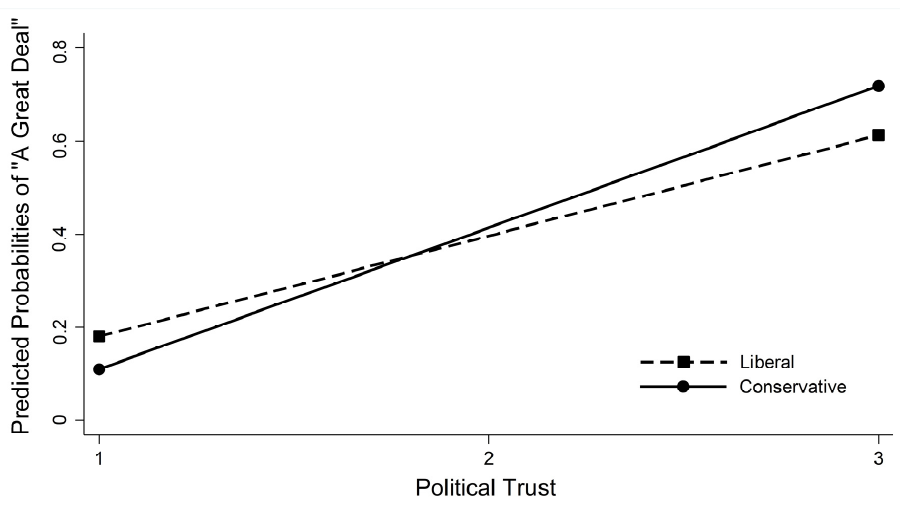
Figure 1. Predicted probabilities of support for “a great deal” of trust in government to ensure vac- cine safety. vaccine